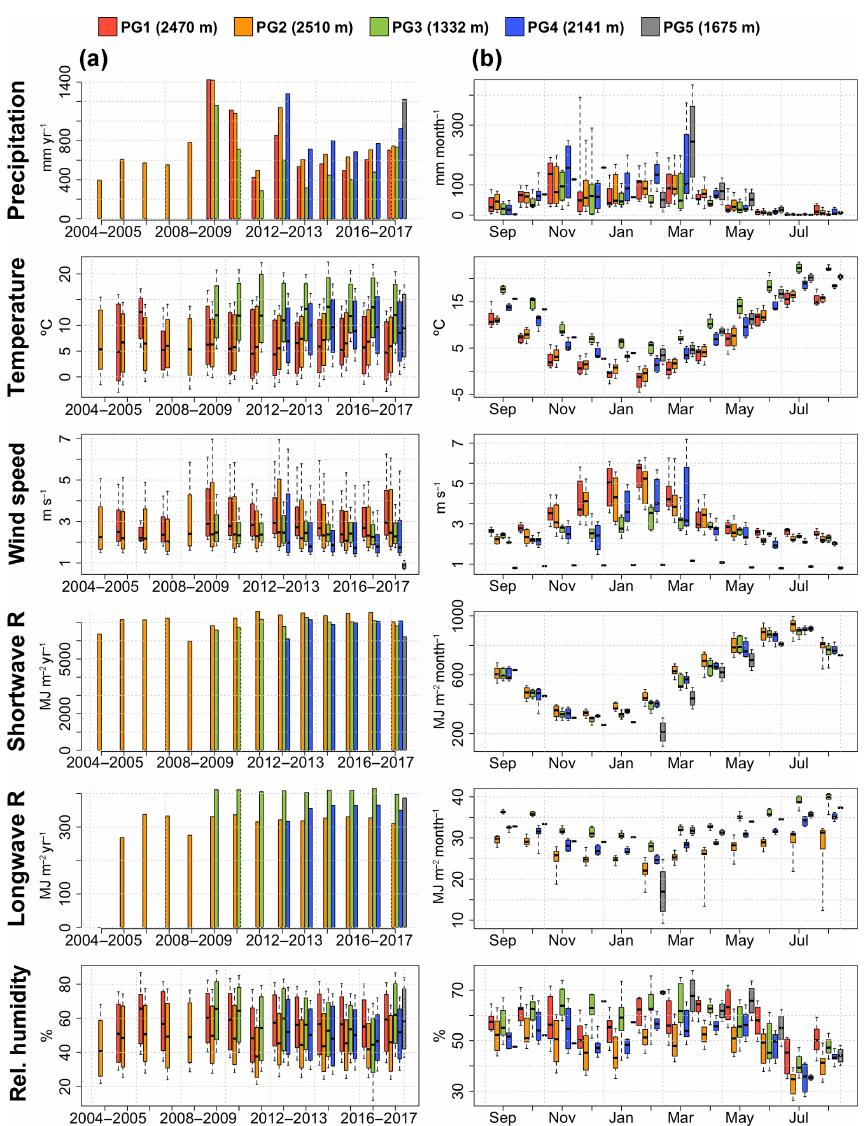
Figure 4. Annual and monthly descriptors of the meteorological variables monitored during 2004–2017 by each weather station in the Guadalfeo Network. Column (a) shows annual precipitation, annual mean daily temperature, annual mean daily wind speed, annual incoming short- and longwave radiation and annual mean air relative humidity. Column (b) shows mean monthly precipitation, temperature, wind speed, incoming short- and longwave radiation and air relative humidity. Box plots show the median values (black line), the interval range and the 10th and 90th percentiles (whiskers) of each sample (series duration in Fig.